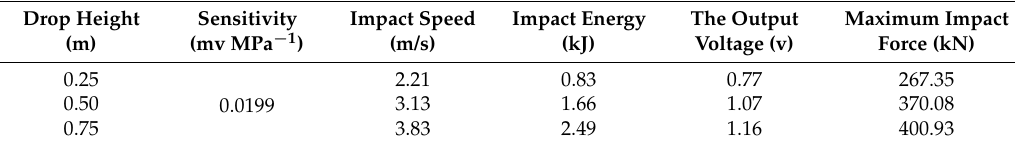
Figure 13. Time history curve of impact force under the second condition. Table 4. The test results of hammer’s impact force.